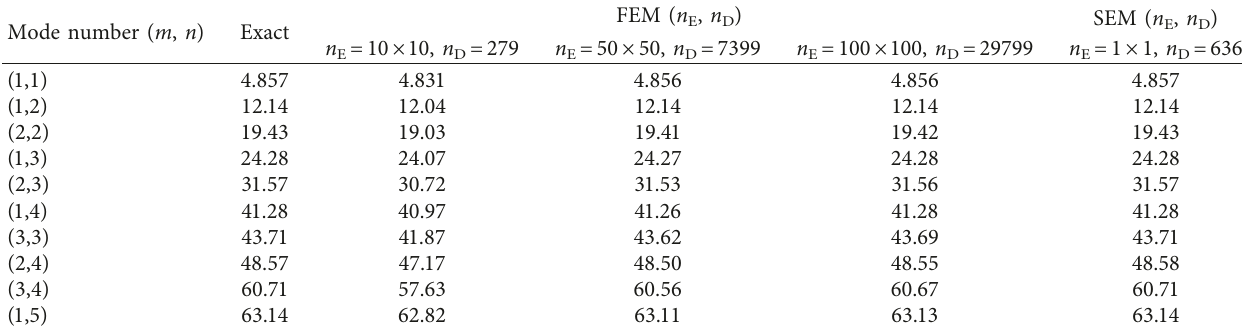
Table 1: Comparison of the natural frequencies (Hz) of the S-S-S-S single-span square plate (Example 1) obtained by the exact theory [37], FEM [38], and